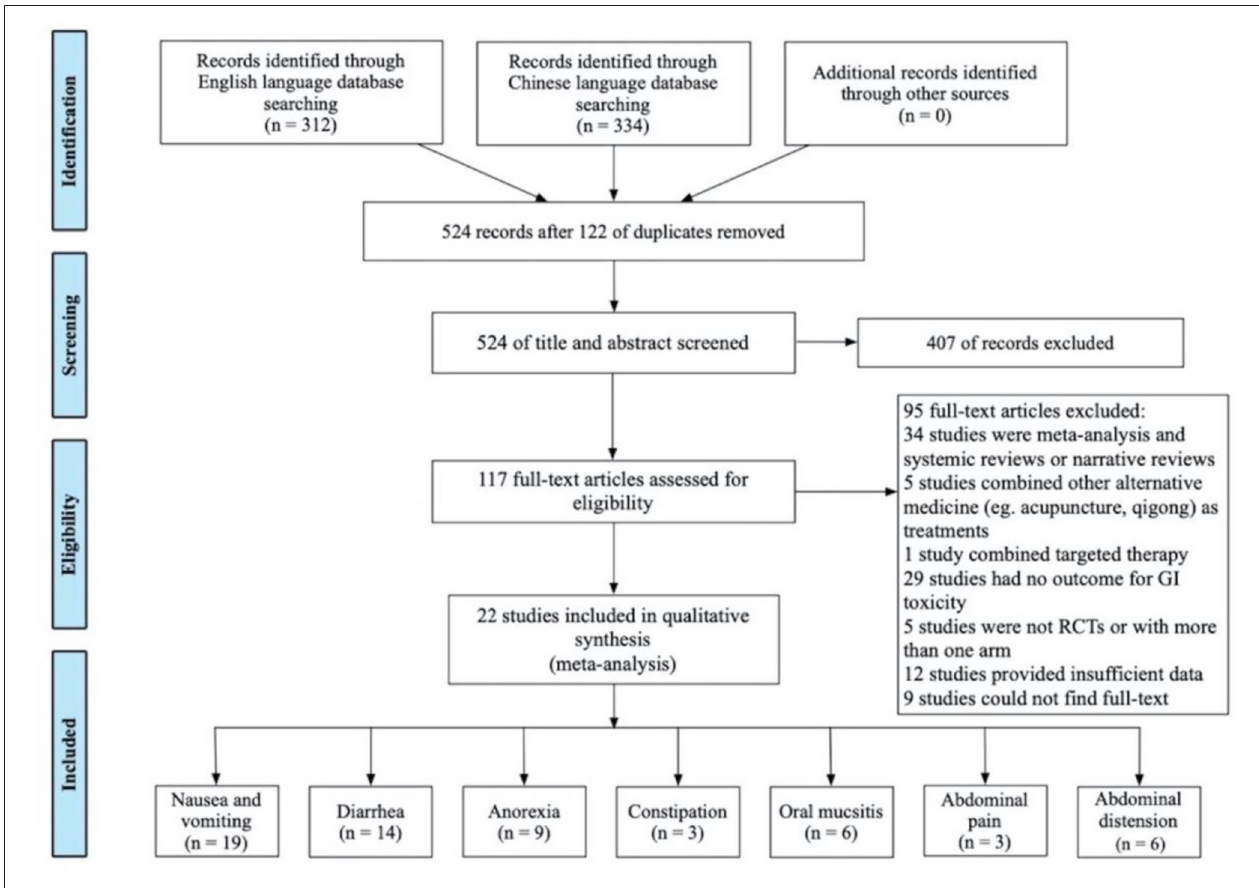
FIGURE 1 | Study selection flowchart based on